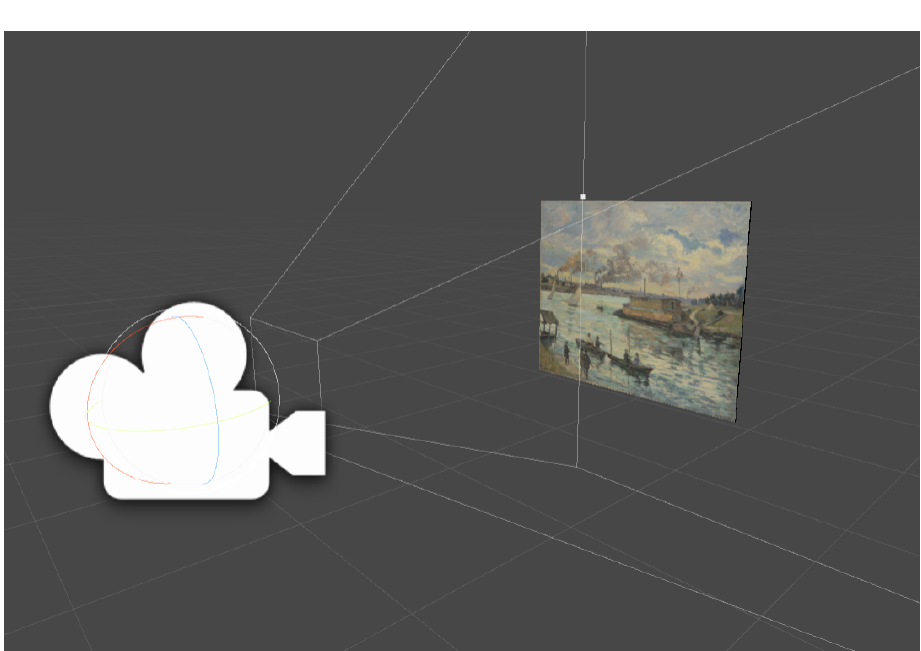
Figure 15. Camera that precisely frames the